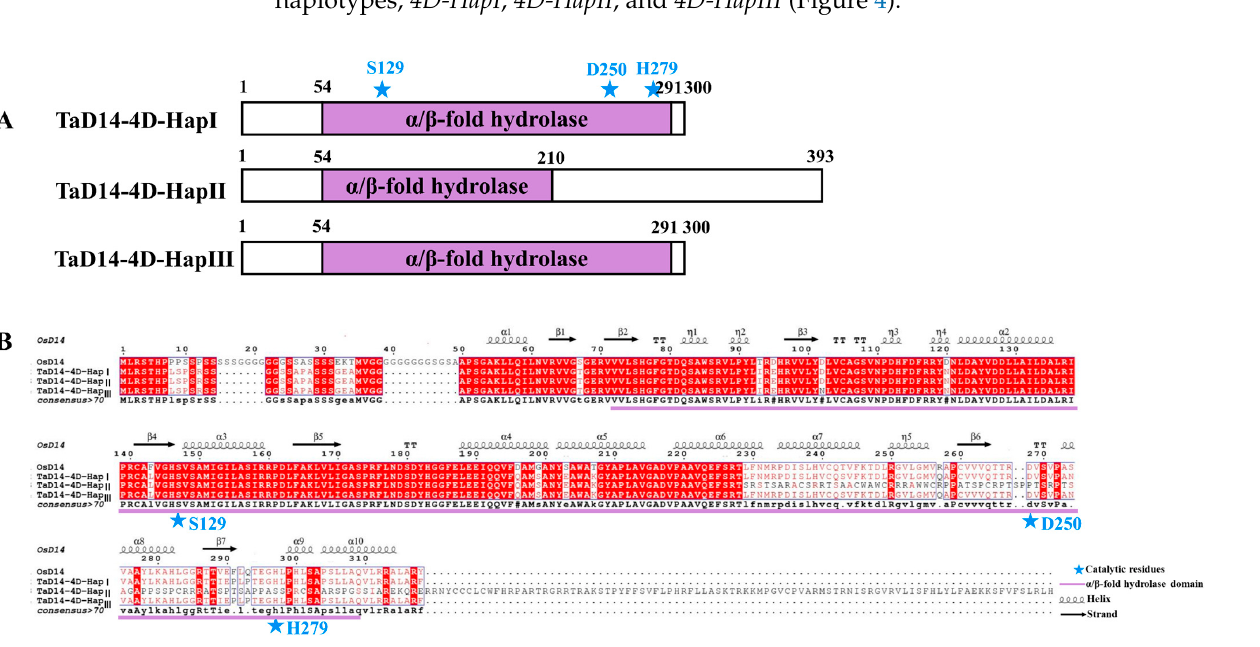
Figure 4. Comparison of protein structures in different haplotypes of TaD14-4D. ( A ) Protein structure in different TaD14-4D haplotypes. The purple boxes represent α / β -hydrolase fold domain and the number above represents the number of amino acids. ( B ) Sequence alignment and structural annotation of TaD14-4D among different haplotypes. Identical and similar residues are highlighted in red and white backgrounds, respectively. The three catalytic residues represented by blue stars, S129, D250, and H279, were deduced from OsD14. The secondary structure of OsD14 was from Nakamura et al. [33]. The purple line indicates α / β -hydrolase fold domain.